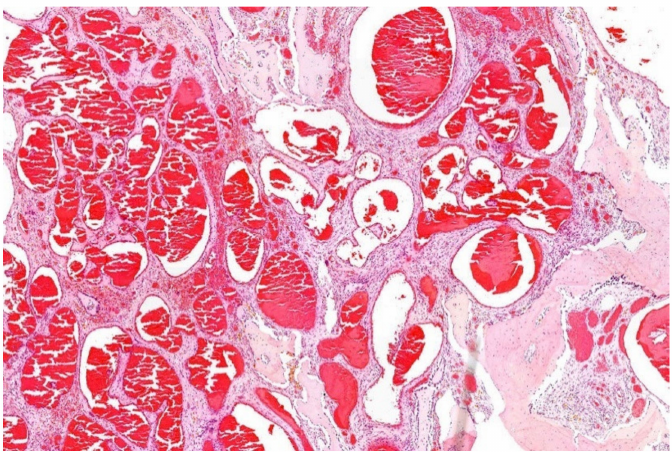
Figure 16. Hemangioma of bone consisting of cavernous blood-filled vessels. Note the surrounding cellular matrix and remodeling of the preexisting bone (HE; 20 × magnification). Recently, a multifocal hemangioma has been described located in the occipital bone and clavicle showing a t(18;22)(q23;q12) with an EWSR1-NFATC1 fusion chimera